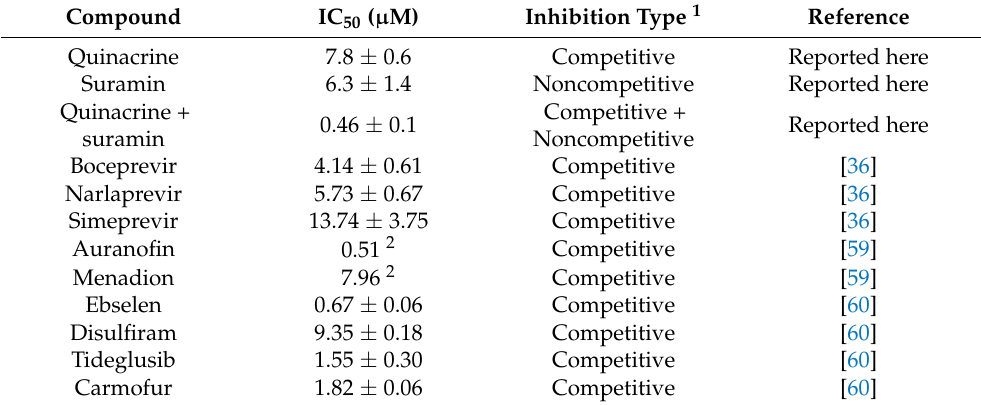
Table 5. Examples of drugs or preclinically tested compounds affecting SARS-CoV-2 3CL pro